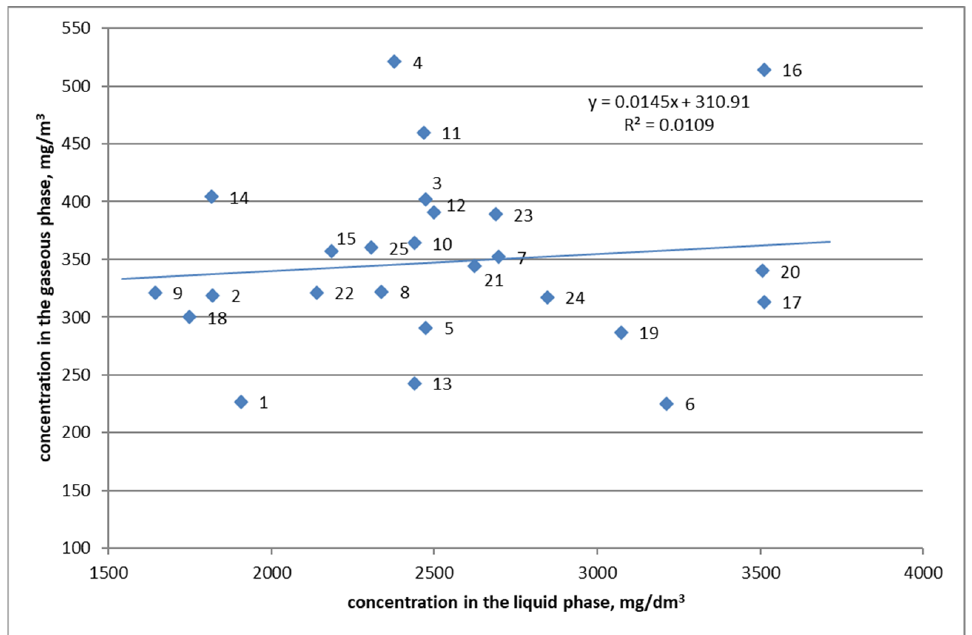
Figure 12. Total concentration of xylenes and ethylbenzene in the liquid and gaseous phases of diesel oil in equilibrium.